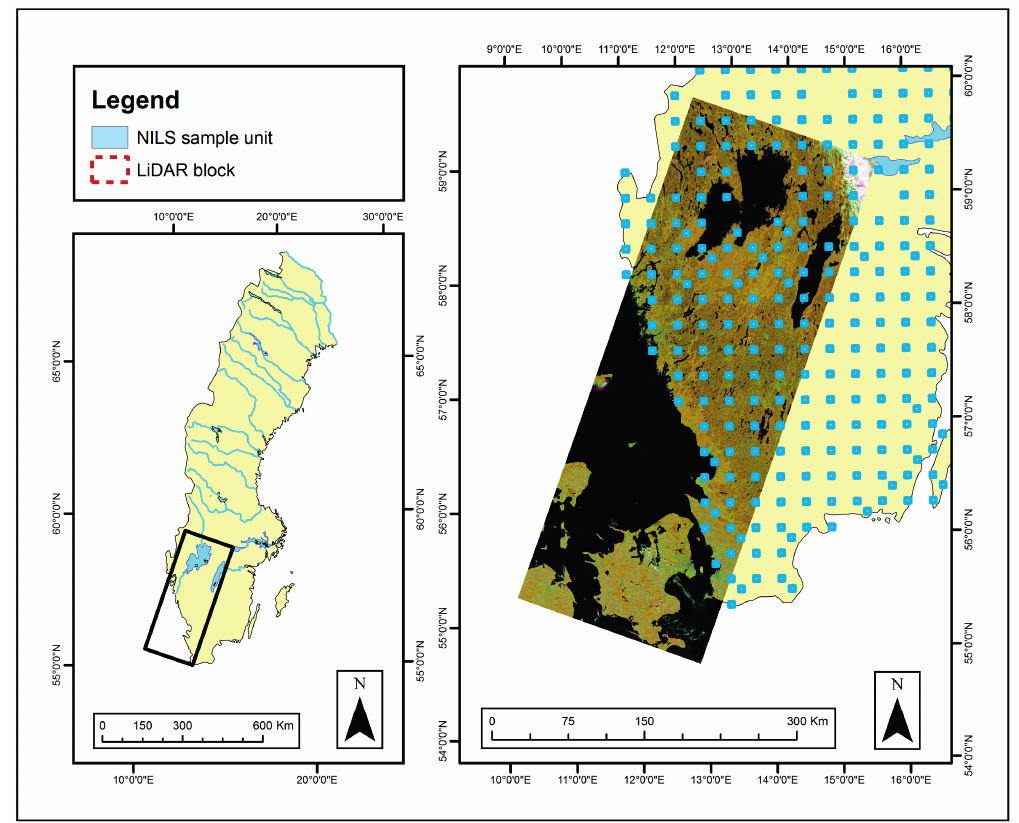
Figure 3. The study area in southwestern Sweden, defined by the extent of three contiguous Landsat 8 images. The lidar blocks are marked in red and the NILS squares are marked in